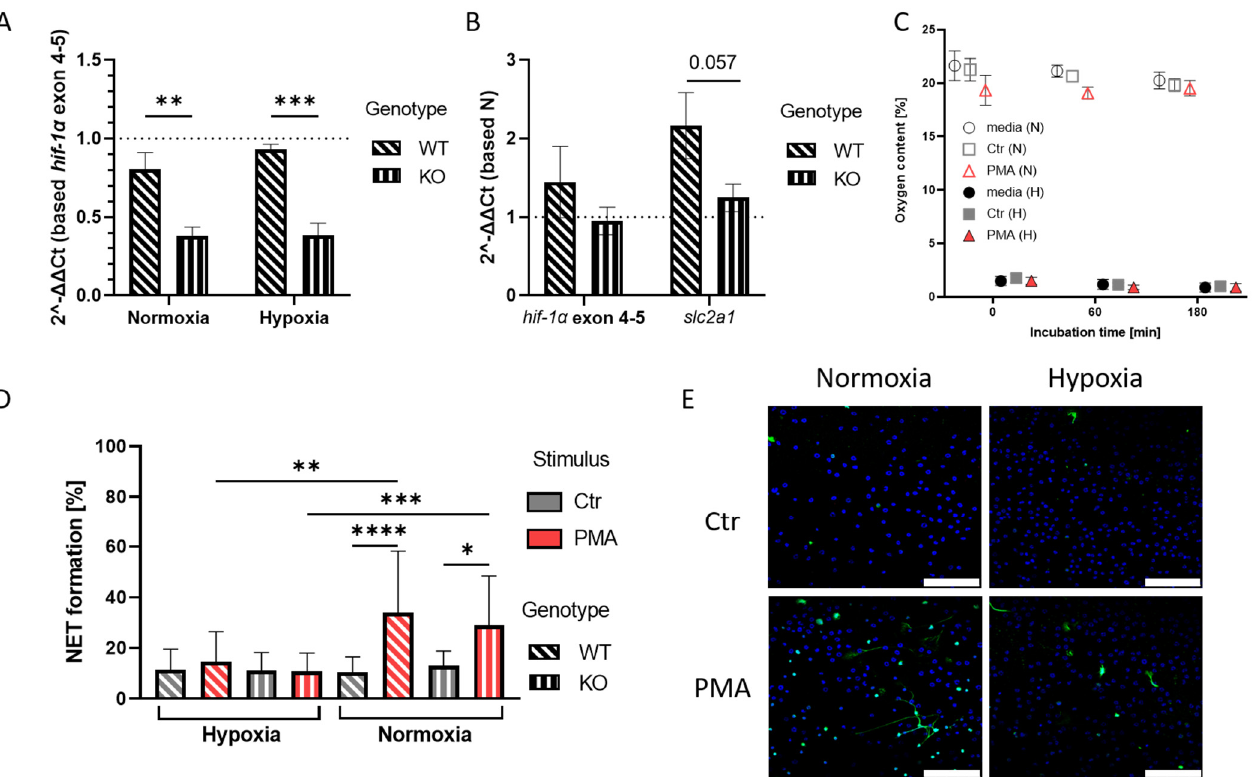
Figure 1. ( A ): The graph shows fold change of hif-1 α exon 2 expression normalized to hif-1 α exon 4-5 expression in KO mice (slanted dashed pattern). The KO shows expression reduced by 42% under normoxia and 55% under hypoxia, compared to the WT samples (straight dashed pattern). Significance was analyzed via 2-way-ANOVA with multiple comparisons. ( B ): Here, the fold change of hif-1 α exon 4-5 expression and HIF-1 α target gene slc2a1 is shown in untreated hypoxia samples, which were normalized to expression levels under normoxia. No upregulation of HIF-1 α target gene in KO samples can be observed. Significance was analyzed via the Man–Whitney test. ( C ): Oxygen levels in hypoxia and normoxia samples during 3 h incubation revealed that PMA stimulation under normoxia led to slightly reduced oxygen levels. Overall, sample oxygen levels remained stable during the incubation time. ( D ): NET formation analysis after 3 h incubation of neutrophils under hypoxia or normoxia. Under normoxia, PMA induced NET formation in both WT and KO cells, while no NET formation was observed under hypoxia. Significance was analyzed via 1-way-ANOVA with multiple comparisons. ( E ): Representative immune fluorescence images of NET formation under different oxygen conditions in the WT mice. Left images show NET formation under normoxia, right images show NET formation under hypoxia, with inhibited NET formation after PMA treatment under hypoxia. Blue: DAPI, green: DNA/Histone1 complexes. Scale bar: 100 µ m. N = 3/4 (WT/KO) for all shown data sets. (* p < 0.05, ** p < 0.01, *** p < 0.001, **** p <